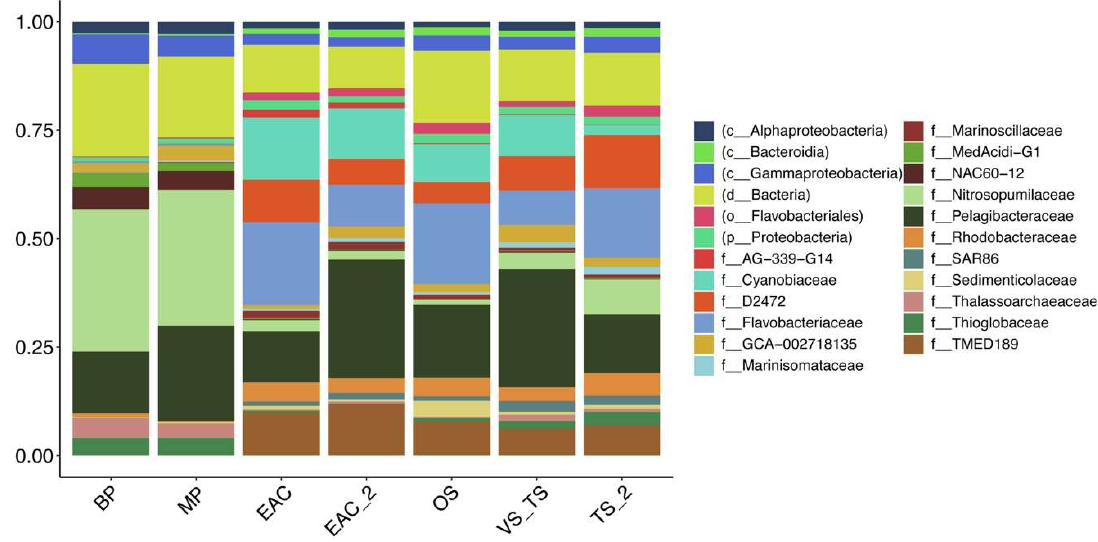
Figure 5. Community composition for the different clusters of the 50 most abundant prokaryotic taxa in the metagenomes represented at the family level. Taxonomy was estimated from SSU rRNA genes (bacteria and archaea), reconstructed from shotgun metagenomes using phyloFlash.